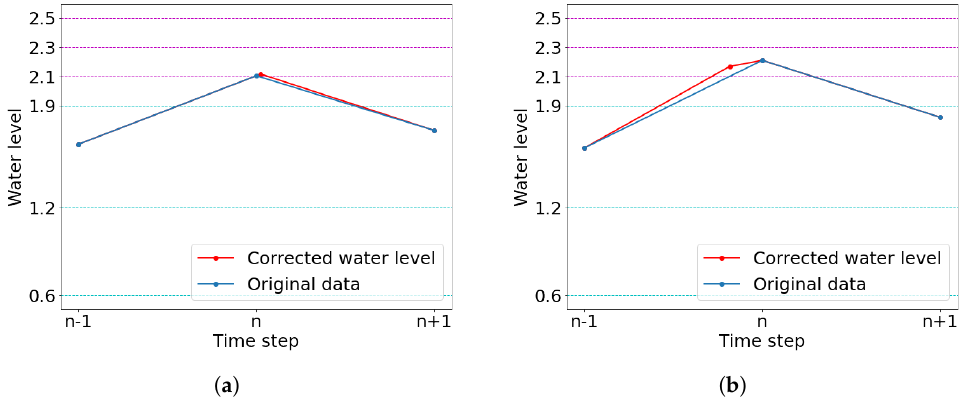
Figure 4. Two sub-cases of case A1. ( a ) Illustration of sub-case A1 (ii): f n − 1 = 1.635, f n = 2.104 and f n + 1 = 1.73. ( b ) Illustration of sub-case A1 (iii): f n − 1 = 1.61, f n = 2.21 and f n + 1 =